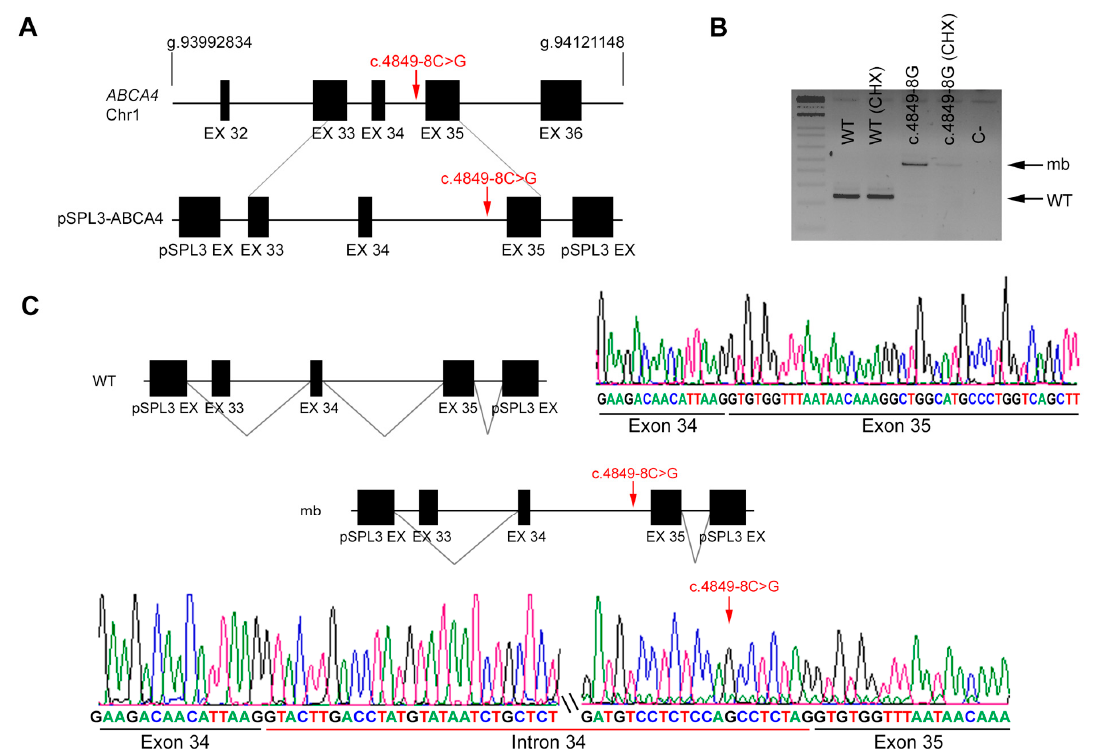
Figure 3. In vitro splicing analysis of the non-canonical splice site (NCSS) variant identified in ABCA4 in patient DBG2. ( A ) Genomic position of the identified NCSS variant in intron 34 of the ABCA4 gene (c.4849-8C > G). Diagram showing the genomic region amplified from patient’s DNA, cloned into the pSPL3 vector. Note that exon 33 was not included in full. ( B ) Analysis of ABCA4 mRNAs from HEK293T cells transfected with either WT or mutant genomic sequences (treated or untreated with cycloheximide, CHX). The band of 247 bp corresponds to the wild-type transcript (WT), whereas cells transfected with pSPL3 carrying the NCSS variant produced one aberrant transcript of 477 bp (indicated as mb). C- indicates the PCR negative control. ( C ) Subsequent Sanger sequencing of cloned individual bands confirmed intron 34 retention due to the NCSS variant.